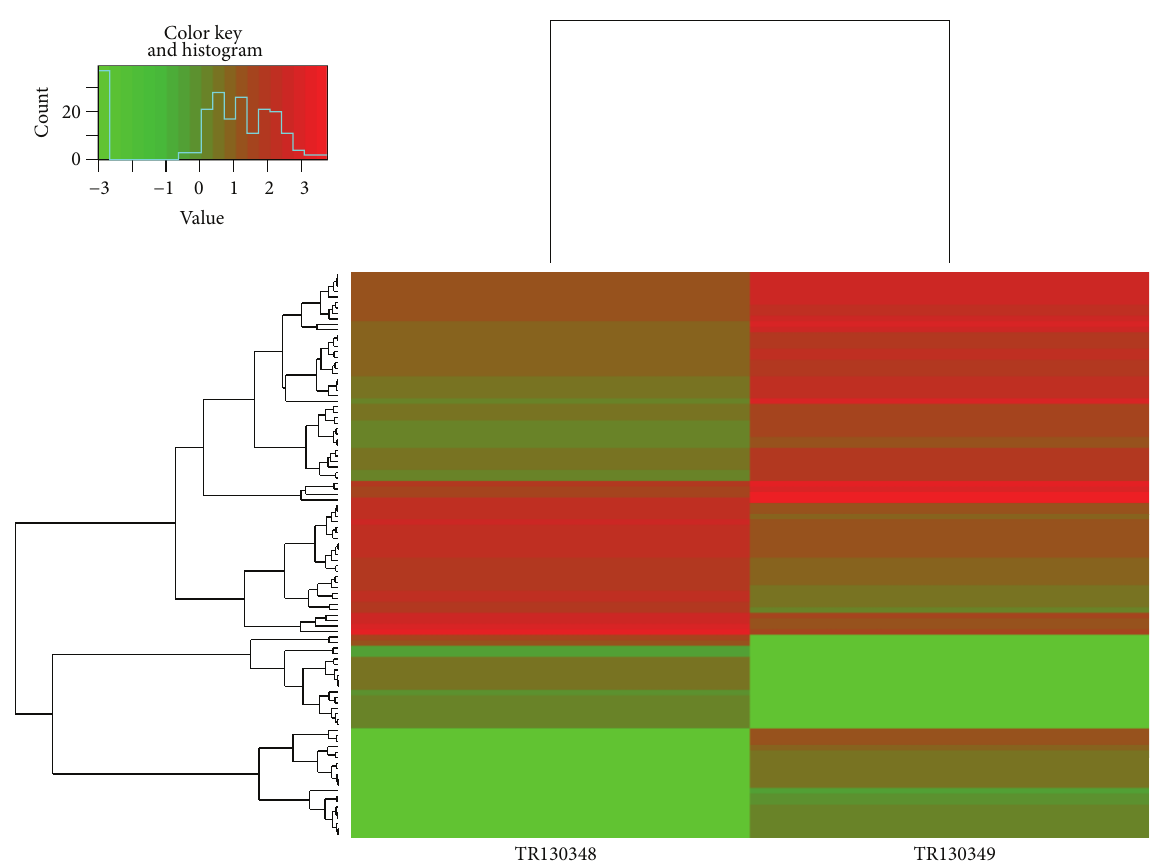
Figure 3: Euclidean distance was used to establish the distance of expression between A (C0, TR130348) and B (C24, TR130349).